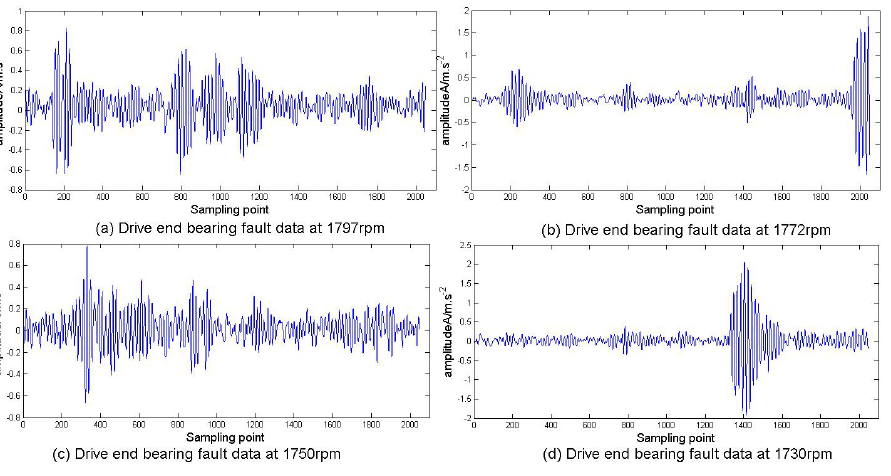
Figure 3. Fault data of inner race of drive end bearing under different